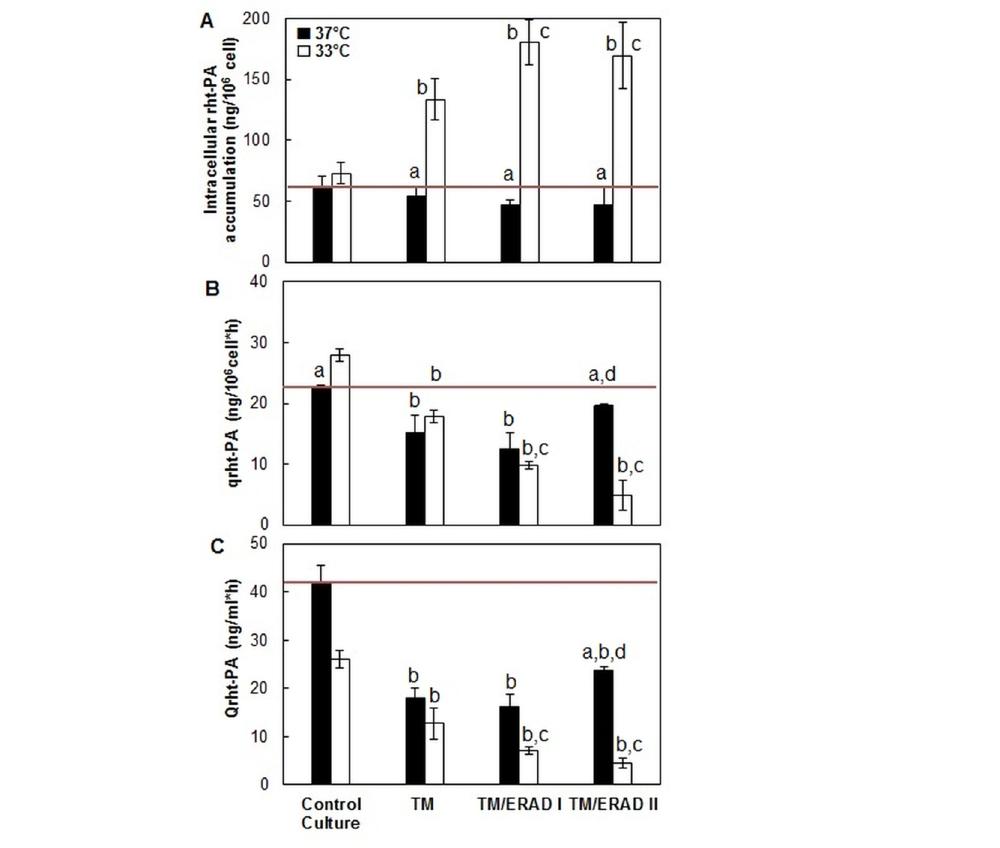
Fig 2. Intracellular accumulation, specific and volumetric productivity of rht-PA at different culture temperatures and under glycosylation/ERAD inhibition, in batch cultures. ANOVA and the Tukey ’ s test. Statistical significance was considered for p < 0.05. a : Significant differences respect to counterpart culture at different T°; b : Significant differences respect to CC; c : Significant differences respect to TM; d : Significant differences respect to TM/ERAD